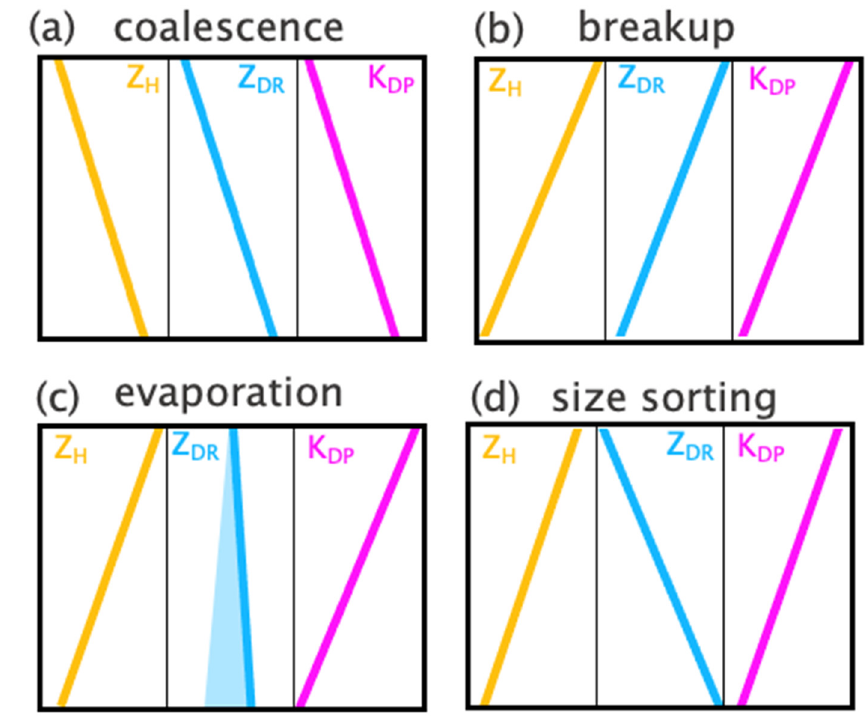
Figure 2. Different microphysical fingerprints for liquid precipitation, including ( a ) coalescence, ( b ) breakup, ( c ) evaporation, and ( d ) size sorting. In panel ( c ), the lighter cyan shading indicates a range of possible fingerprints for Z DR , based on work by [45].